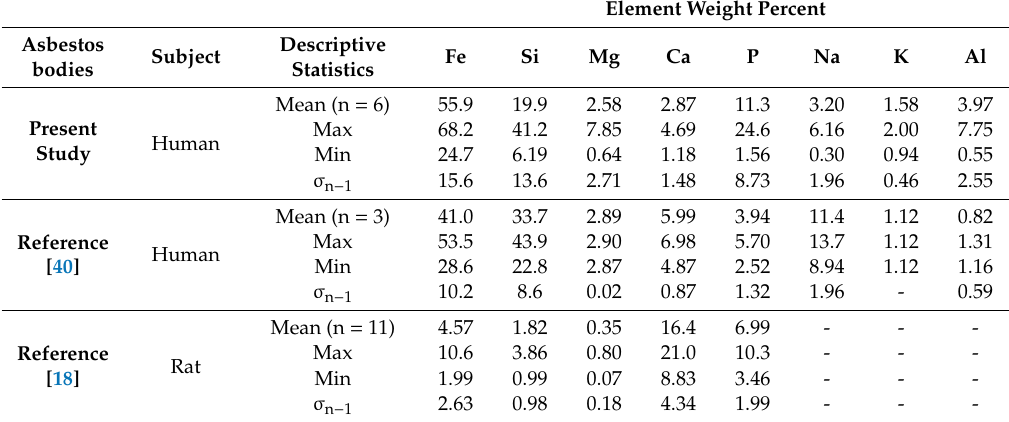
Table 3. EDX semi-quantitative chemical composition of asbestos bodies. For comparison, data for asbestos bodies recovered from another human subject [40] and from rat lungs ( in vivo animal tests [18]) are given as